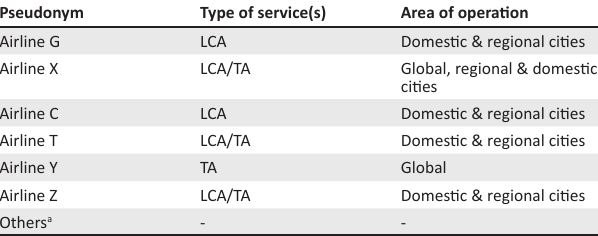
TABLE 1: South African owned airlines. Pseudonym Type of service(s) Area of